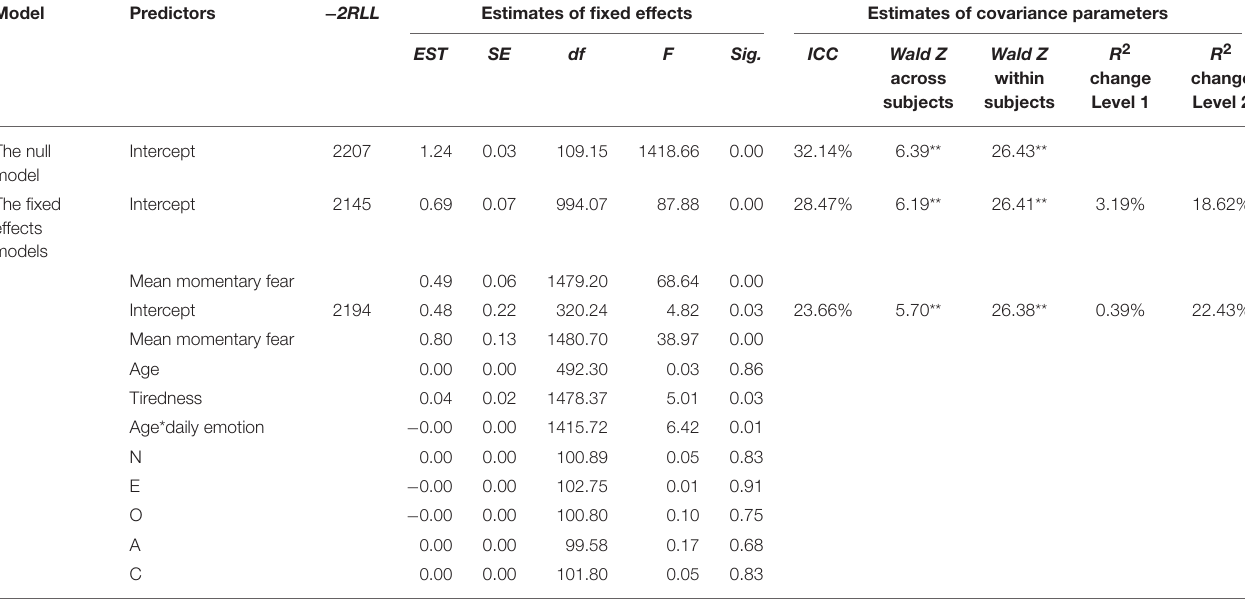
TABLE 2 | The evening ratings of fear—results of the mixed models analysis of the null model and fixed effects random intercept model.